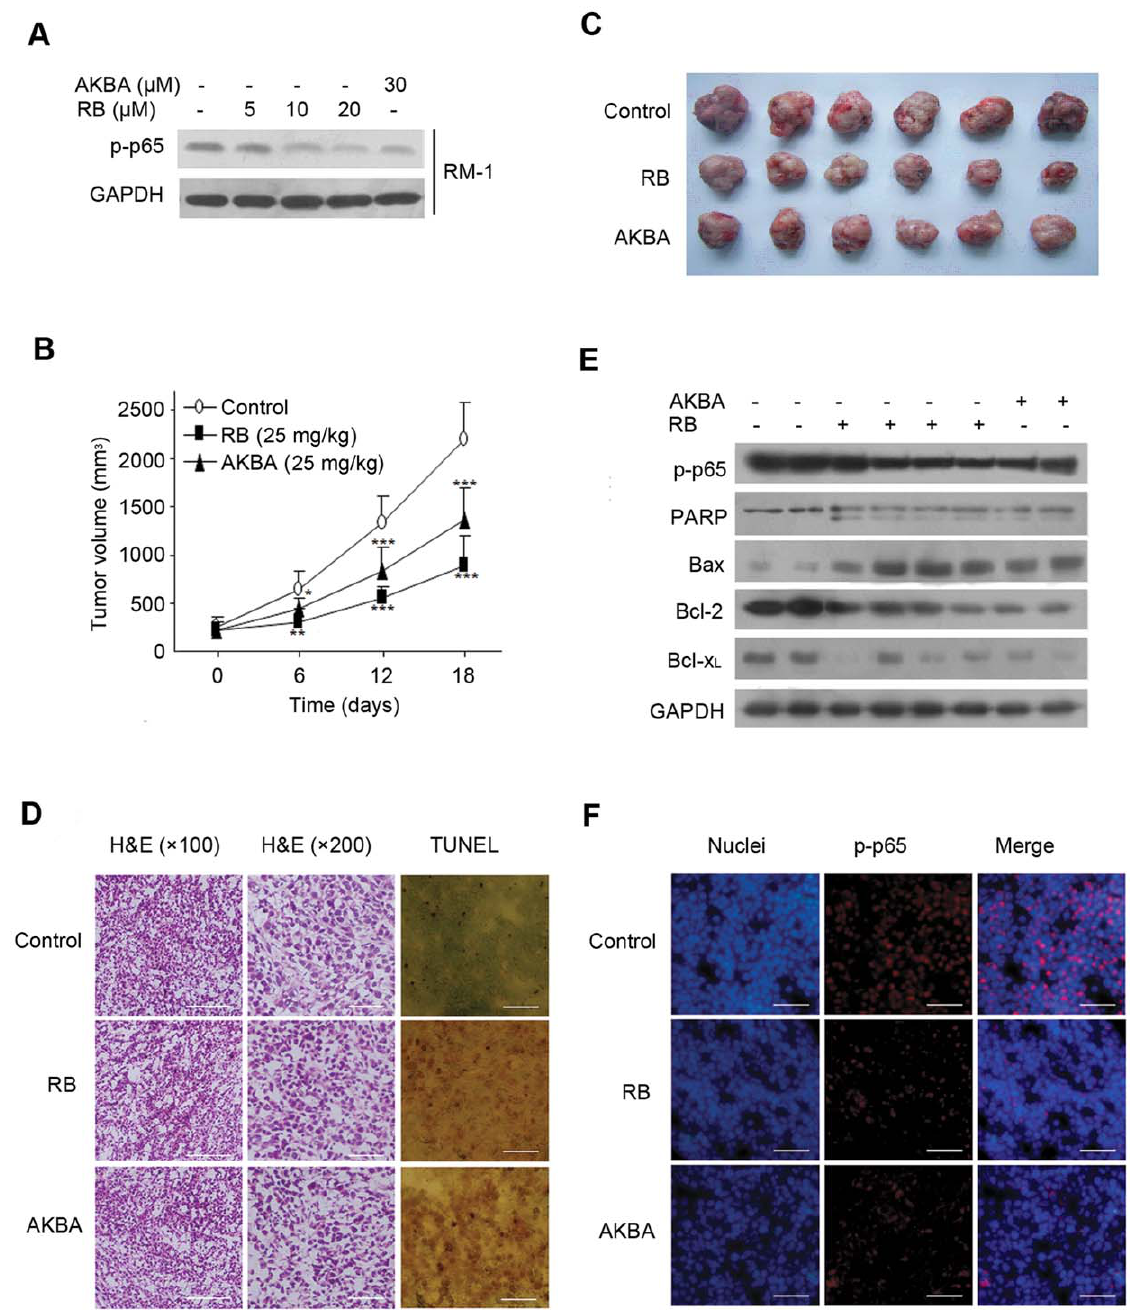
Figure 6. RB inhibits growth of RM-1 homografts in C57BL/6 mice and triggers apoptosis. (A) RB and AKBA concentration-dependently inhibited the Ser-536 phosphorylation of p65 in RM-1 cells. GAPDH served as the loading control. (B) RB (25 mg/kg) reduced the tumor volumes in RM-1-bearing C57BL/6 mice versus the control group, AKBA serving as positive control. 0.2 6 10 6 RM-1 cells were s.c. injected into the dorsal region of right side, and after 7 days, the animals were treated intraperitoneally with RB (25 mg/kg), AKBA (25 mg/kg) or medium alone (control) once daily for 18 days, as described in Materials and Methods , n=6 per group; mean 6 SD; p , 0.05 (*), p , 0.01 (**), p , 0.001(***) versus medium control group, respectively. (C) Representative tumors from the three groups are shown. (D) H&E and TUNEL-dependent staining of RM-1 tumor tissue sections. (Scale bar, 100 m m). (E) Western blot analysis of p–p65, PARP, Bax, Bcl-2, and Bcl-x L expression in 2 tumor tissue samples treated with medium, 4 samples with RB and 2 samples with AKBA. (F) Immunofluorescence for p–p65 analysis of tumor tissues. (Scale bar, 100 m m). doi:10.1371/journal.pone.0038000.g006 nuclear translocation and DNA binding activity of p65. The inhibition of NF- k B in PCa cells. Overexpression and knockdown inhibitory effect on NF- k B activity by RB was also reflected by the experiments supported the observations that the reduction of p65 reduced expressions of NF- k B-dependent genes such as bcl-2, bcl- by RB was crucial in its apoptotic modulation. In addition to PCa x L , cyclin d1, and survivin , and the final consequence of the cells, suppression of NF- k B activation by RB was observed in